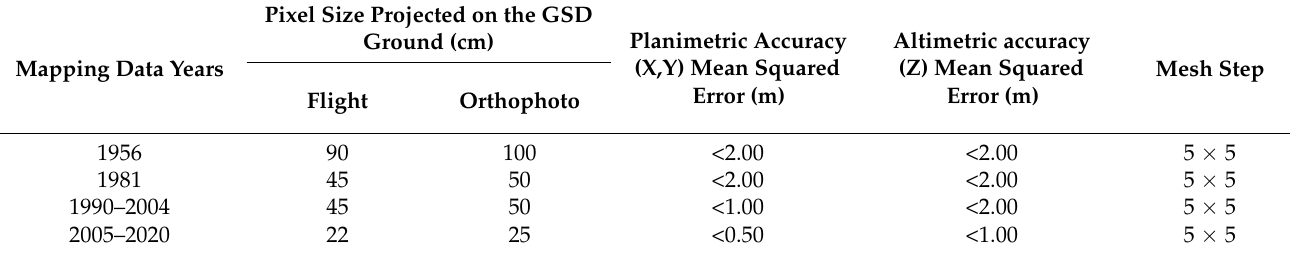
Table 2. Technical characteristics of georeferenced data